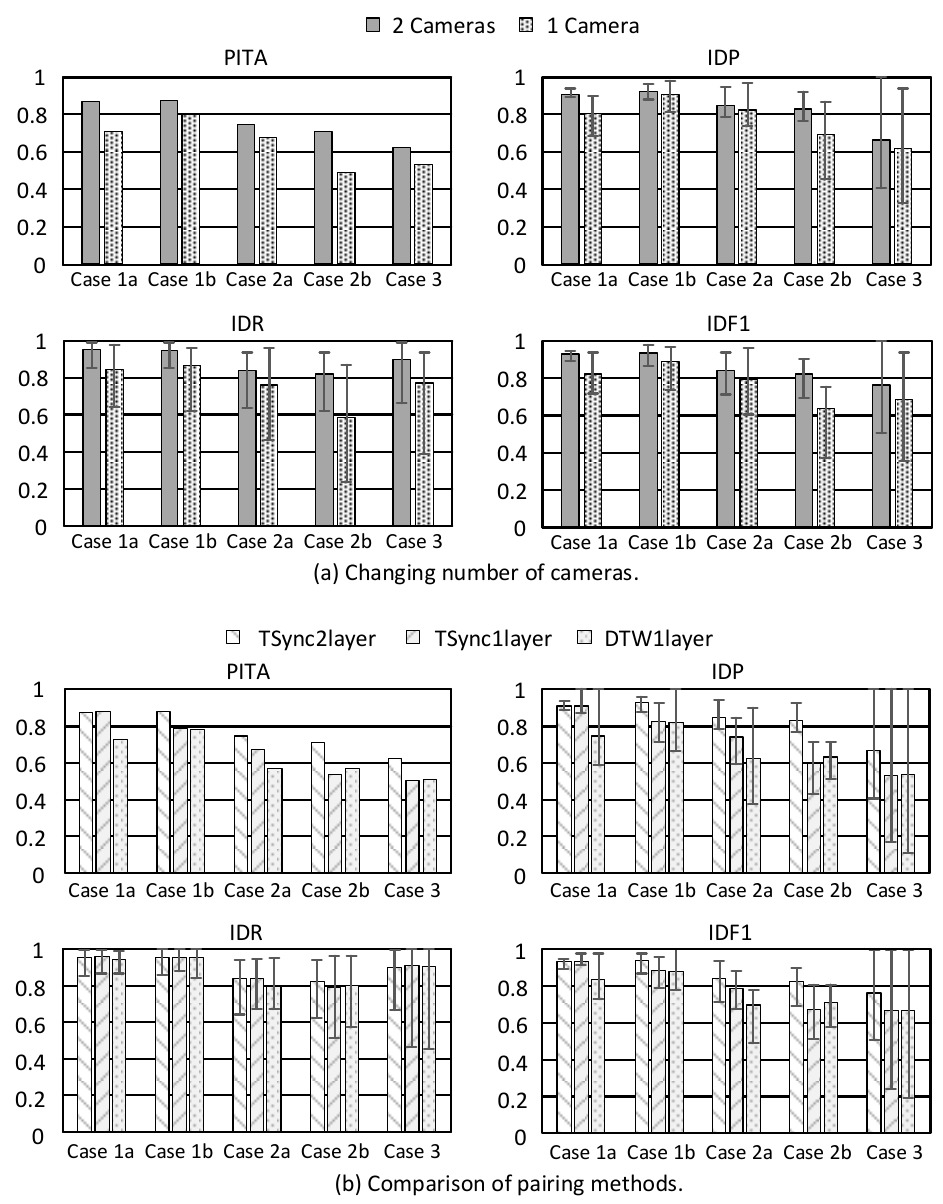
Figure 10. Pairing accuracy. Table 3. Comparison of Per-person